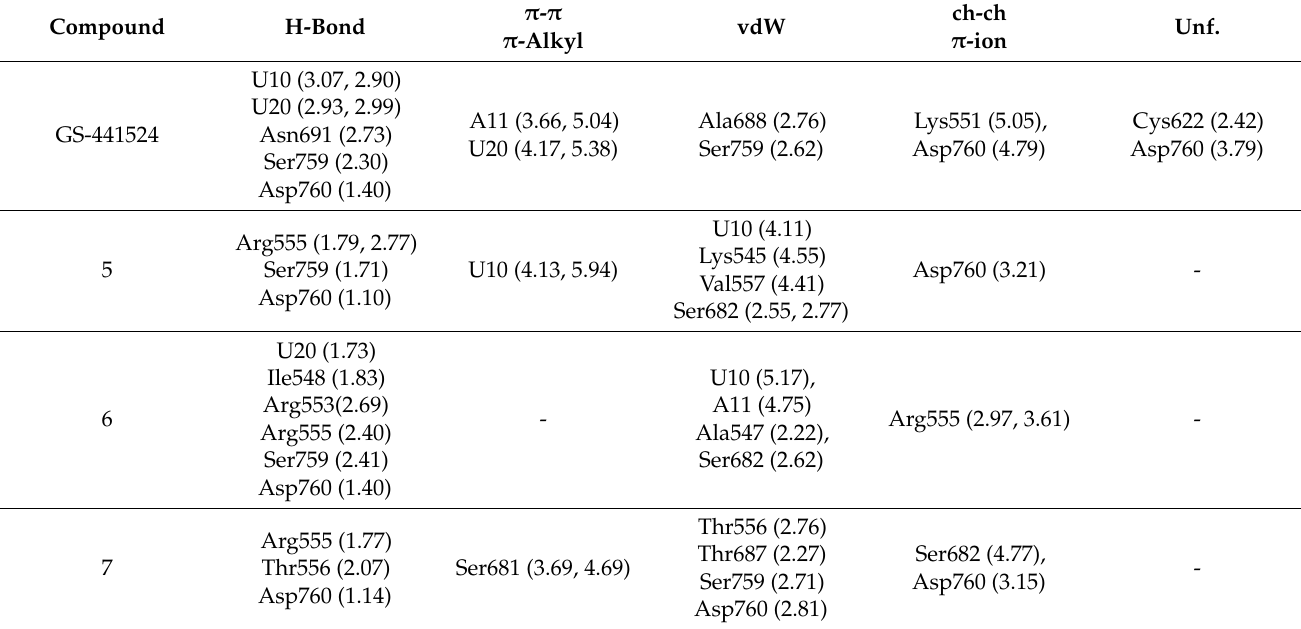
Table 2. Interactions (H-bond, π - π or π -alkyl, van der Waals, charge–charge or π -on and unfavorable) and in brackets the relative distance in Å evaluated by docking calculations of compounds 5 – 11 and remdesivir metabolite, each of them linked to RNA in the receptor pocket of free RdRp (7BV2).